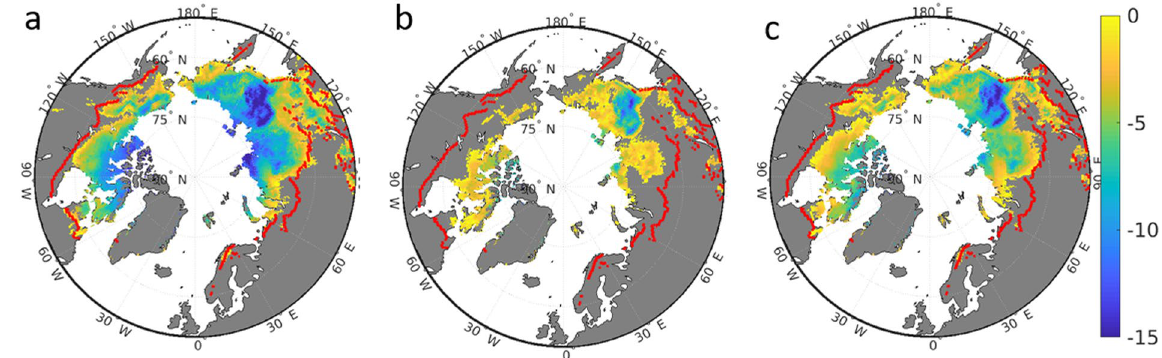
Figure 5. Spatial details of permafrost temperature (°C, 4–10 m average). ( a ) CNTL experiment during 1990–2009. ( b ) CNTL experiment during 2090–2099. ( c ) PlPark experiment during 2090–2099. Grey color denotes land outside the JSBACH estimate of permafrost zone. The red line represents the observation-based 32 contemporary southern boundary of continuous and discontinuous permafrost.